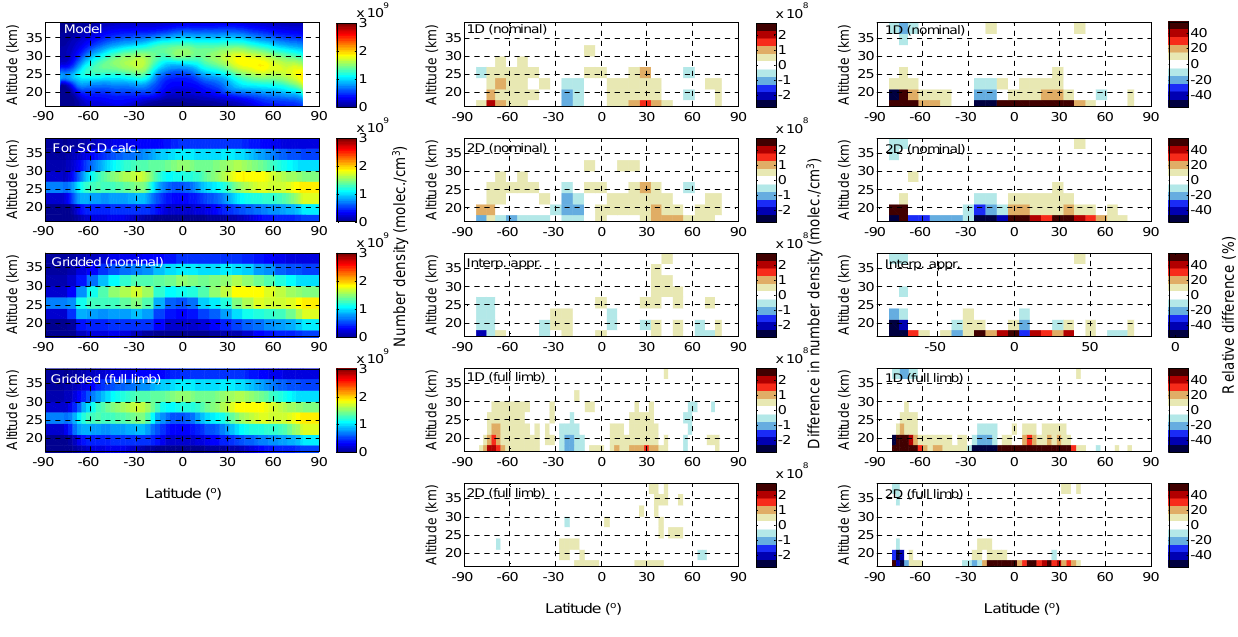
Fig. A3. Same as Fig. 15 but for 15 September 2007.